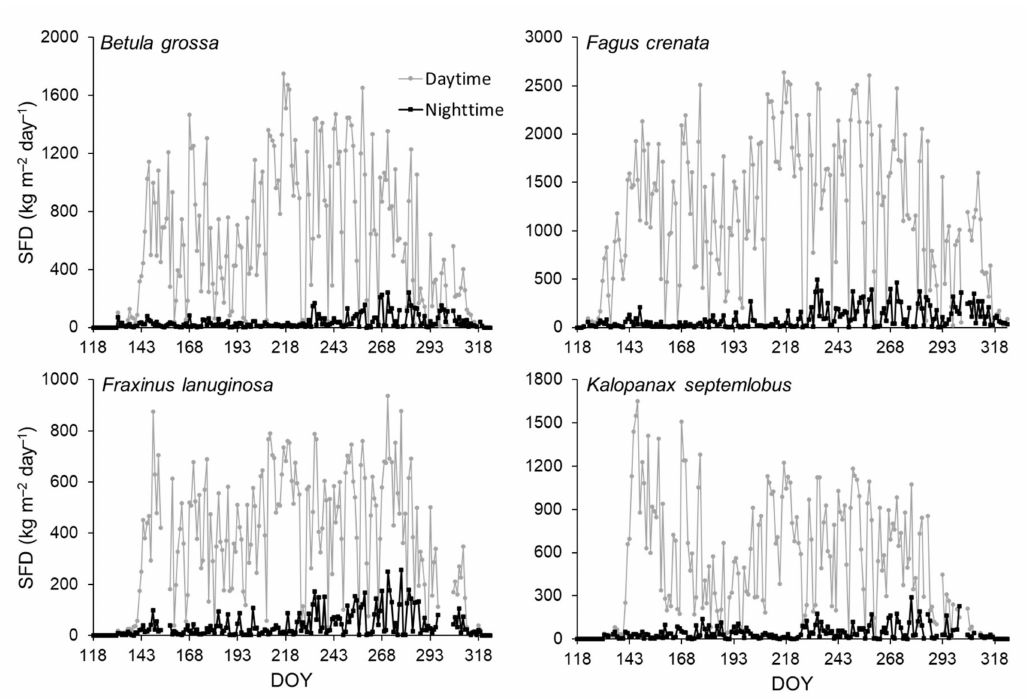
Figure A4. Seasonal dynamics of daytime and nighttime sap flux density (SFD) for four representative trees measured in 2019. Nighttime SFD gradually increased from spring to autumn and was found in 19 of the 33 individuals. Abbreviation: DOY, day of the